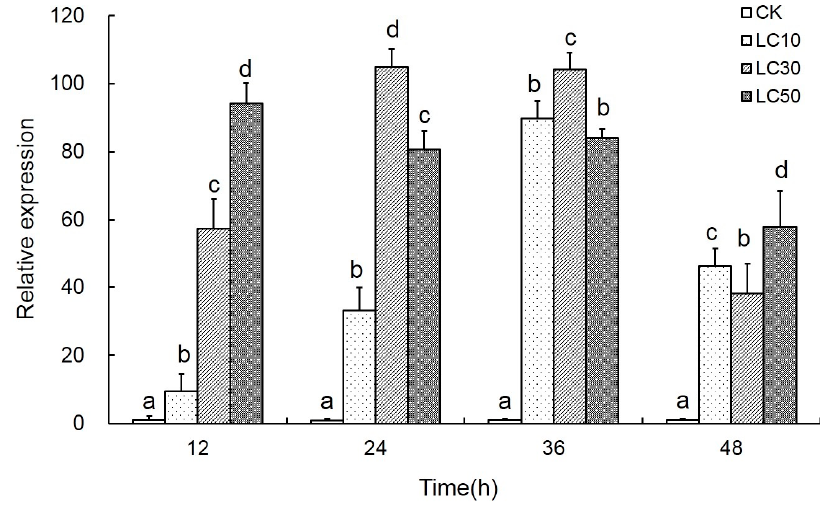
Figure 5. Relative expression levels of the TcPMCA1 gene in adult female Tetranychus cinnabarinus exposed LC 10 (0.219 mg mL − 1 ), LC 30 (0.581 mg mL − 1 ), and LC 50 (1.142 mg mL − 1 ) scopoletin. Expression